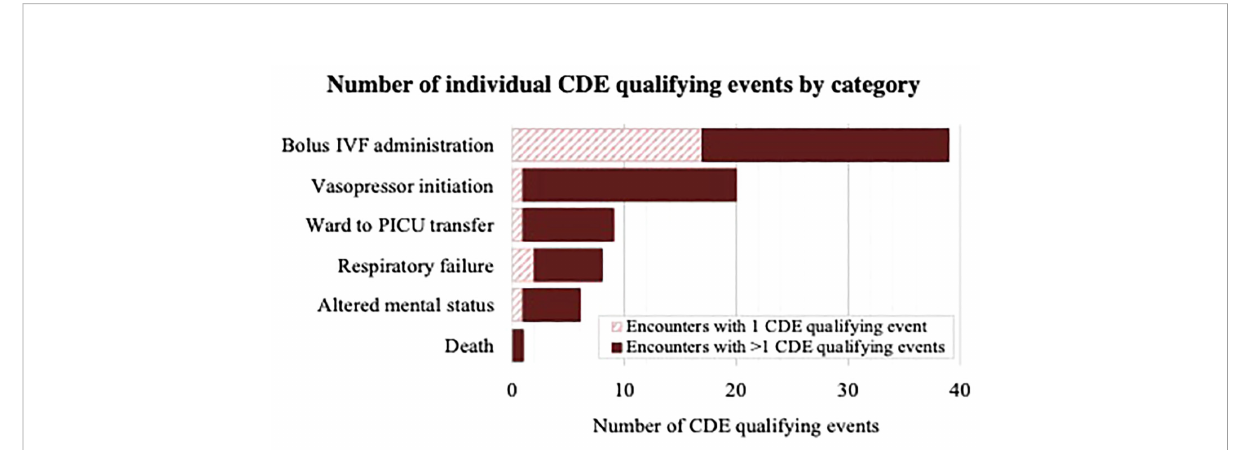
FIGURE 2 Diagram demonstrating number of CDE qualifying events per category (bolus IVF administration, vasopressor initiation, ward to PICU transfer, respiratory failure, altered mental status, death) among encounters with one CDE qualifying event and encounters with multiple CDE qualifying events. IVF, Intravenous fl uid; PICU, Pediatric intensive care